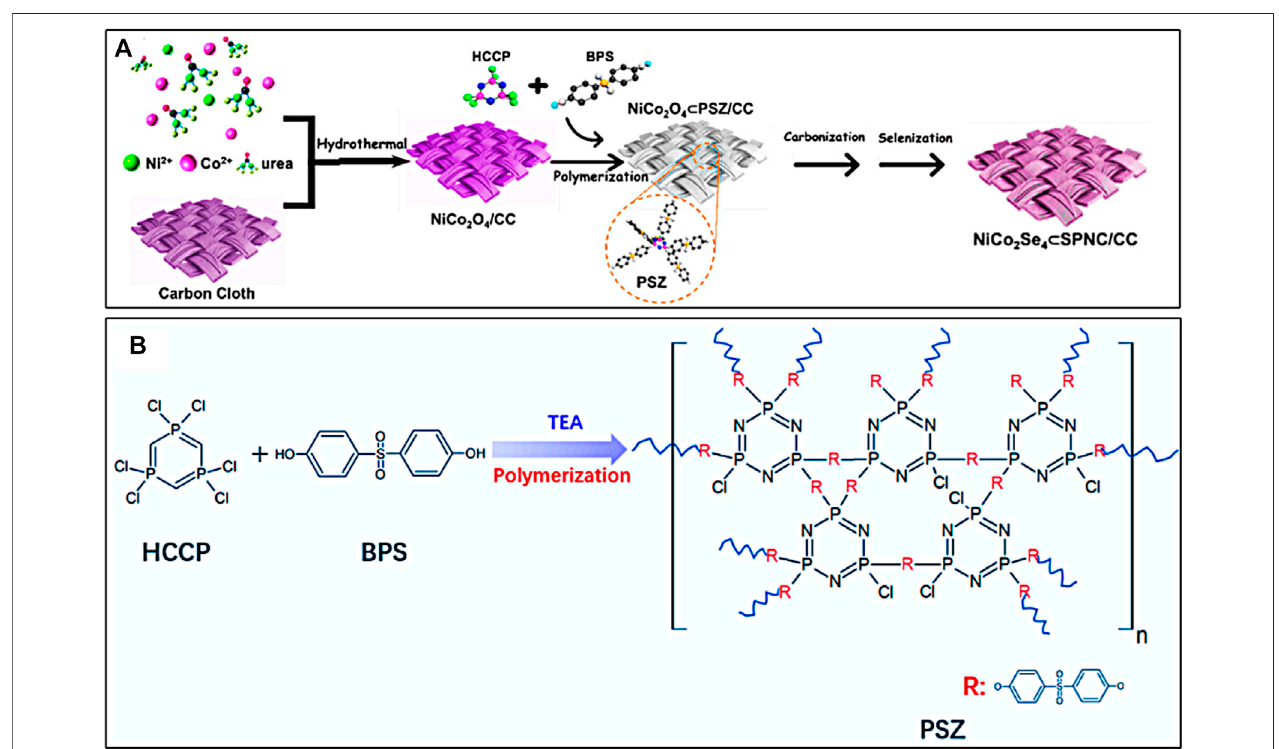
FIGURE1|(A) SchematicillustrationforthepreparationofNiCo 2 Se 4 ⊂ SPNC/CCand (B) thepoly-condensationprocessofHCCPandBPSinthepresenceofTEA.